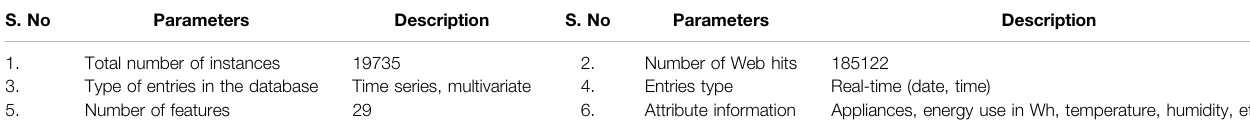
TABLE 2 | Description of the database used for simulation purposes (Candanedo, 2017).